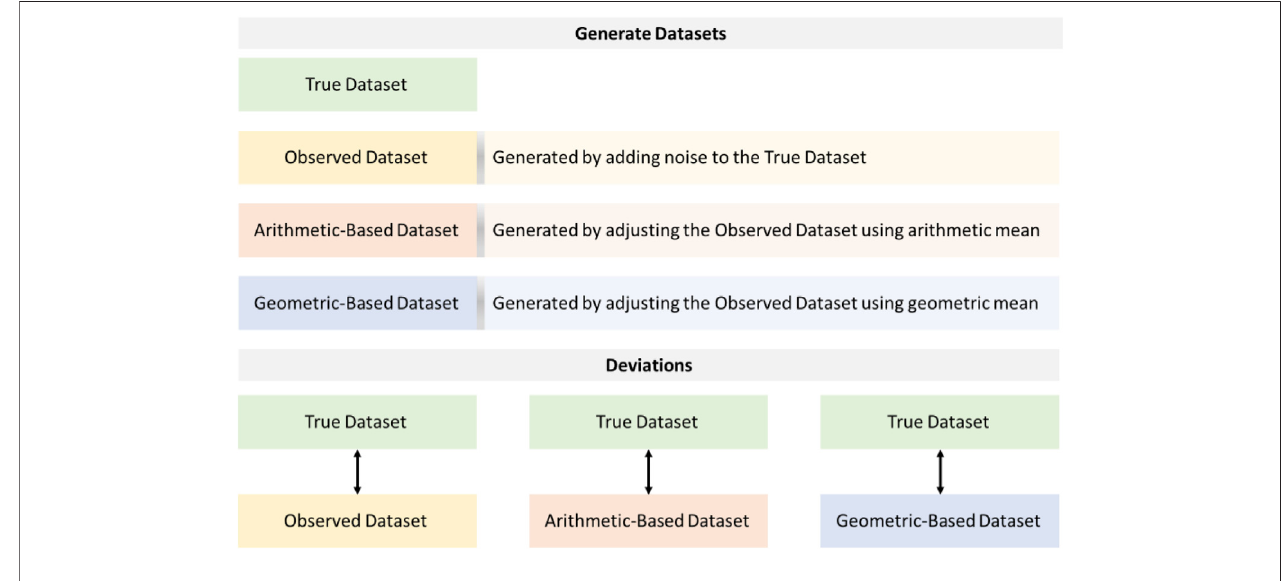
FIGURE 5 | Overview of the validation process of the mathematical model.